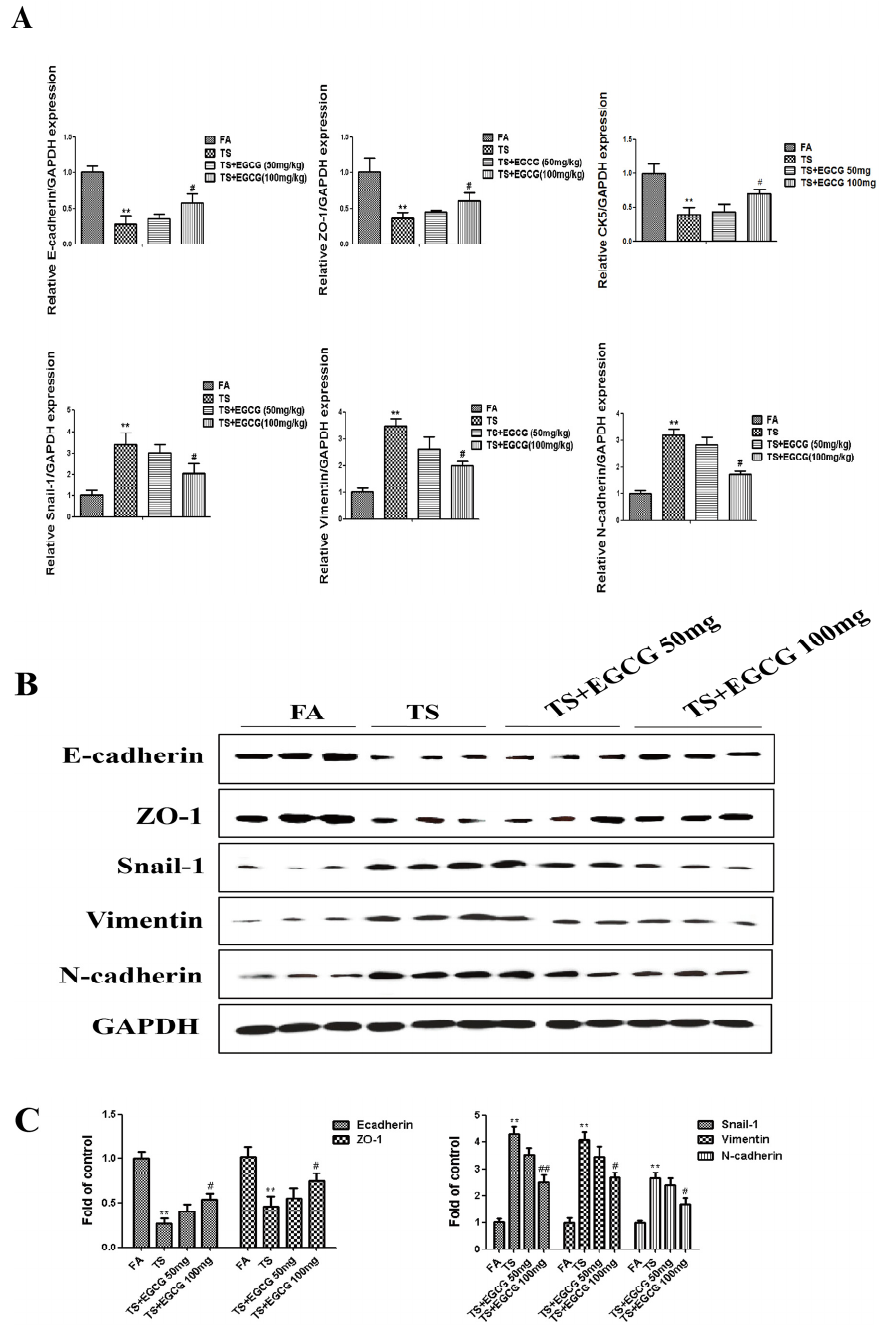
Figure 5. EGCG attenuated tobacco smoke ‐ induced alterations of epithelial ‐ mesenchymal transition markers in the stomach of mice. ( A ) qRT ‐ PCR analyses of E ‐ cadherin, ZO ‐ 1, CK5, Snail ‐ 1, Vimentin, and N ‐ cadherin mRNAs; ( B ) Western blotting analyses of E ‐ cadherin, ZO ‐ 1, Snail ‐ 1, Vimentin, and N ‐ cadherin proteins; ( C ) Densitometric analyses of Western blotting. Data are expressed as mean ± SD. ** p < 0.01, compared with FA control; # p < 0.05, compared with TS; ## p < 0.01, compared with TS. FA = filtered air; TS = tobacco smoke.